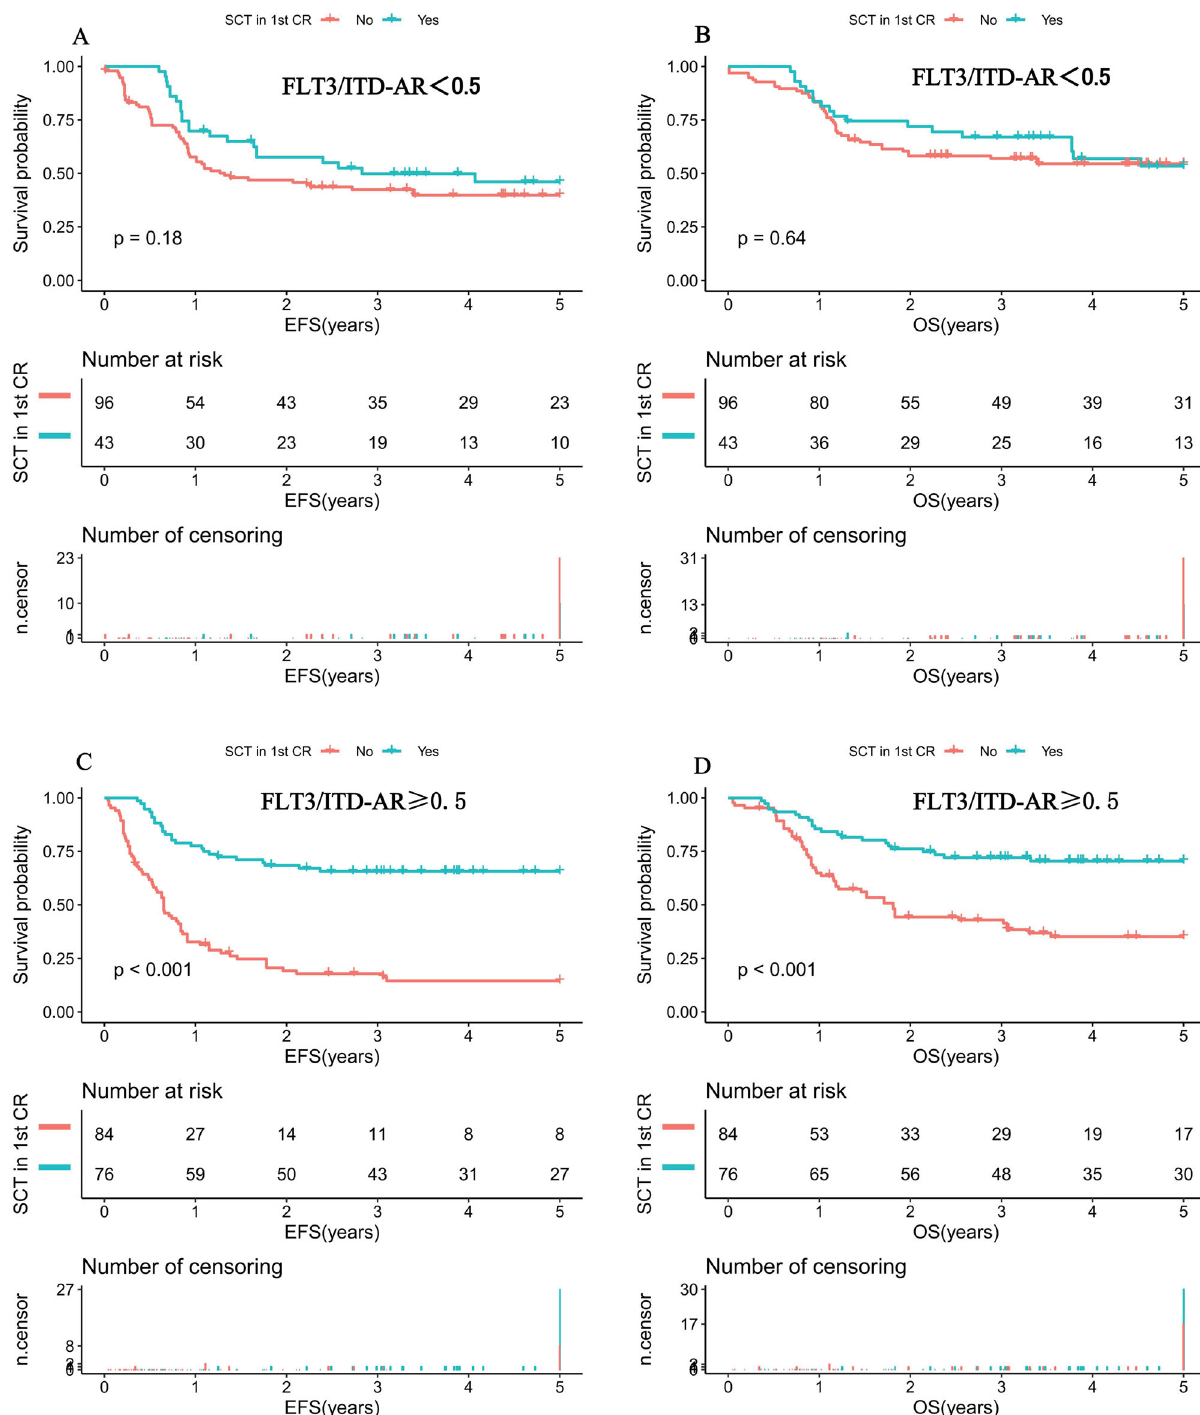
Fig. 5 Survival curves of pediatric AML patients according to different FLT3/ITD AR and SCT status. A Probability of EFS for patients with low FLT3/ ITD AR according to SCT status. B Probability of OS for patients with low FLT3/ITD AR according to SCT status. C Probability of EFS for patients with high FLT3/ITD AR according to SCT status. D Probability of OS for patients with high FLT3/ITD AR according to SCT status. AML acute myeloid leukemia, SCT stem cell transplantation, CR complete remission, AR allelic ratio, EFS event-free survival, OS overall survival. EFS and OS were evaluated by the Kaplan – Meier method and compared by log-rank test. Source data are provided as a Source Data fi